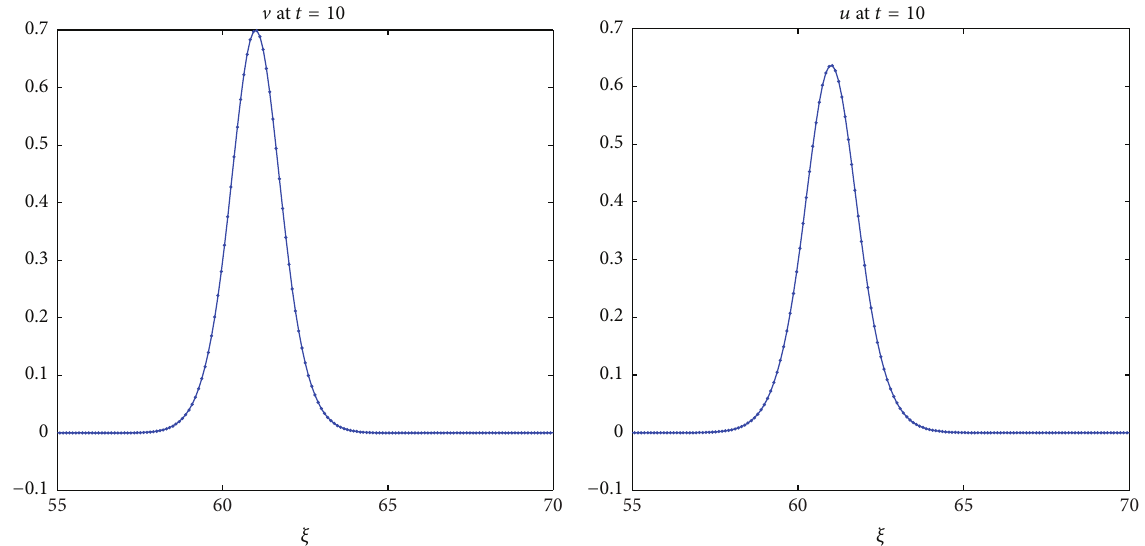
Figure 10: Evolution of a solitary wave solution of system (75) for 𝛼 = 𝛽 = 0.3 , 𝜎 = 0.3 , and wave speed 𝑐 = 1.1 , using numerical scheme (83).